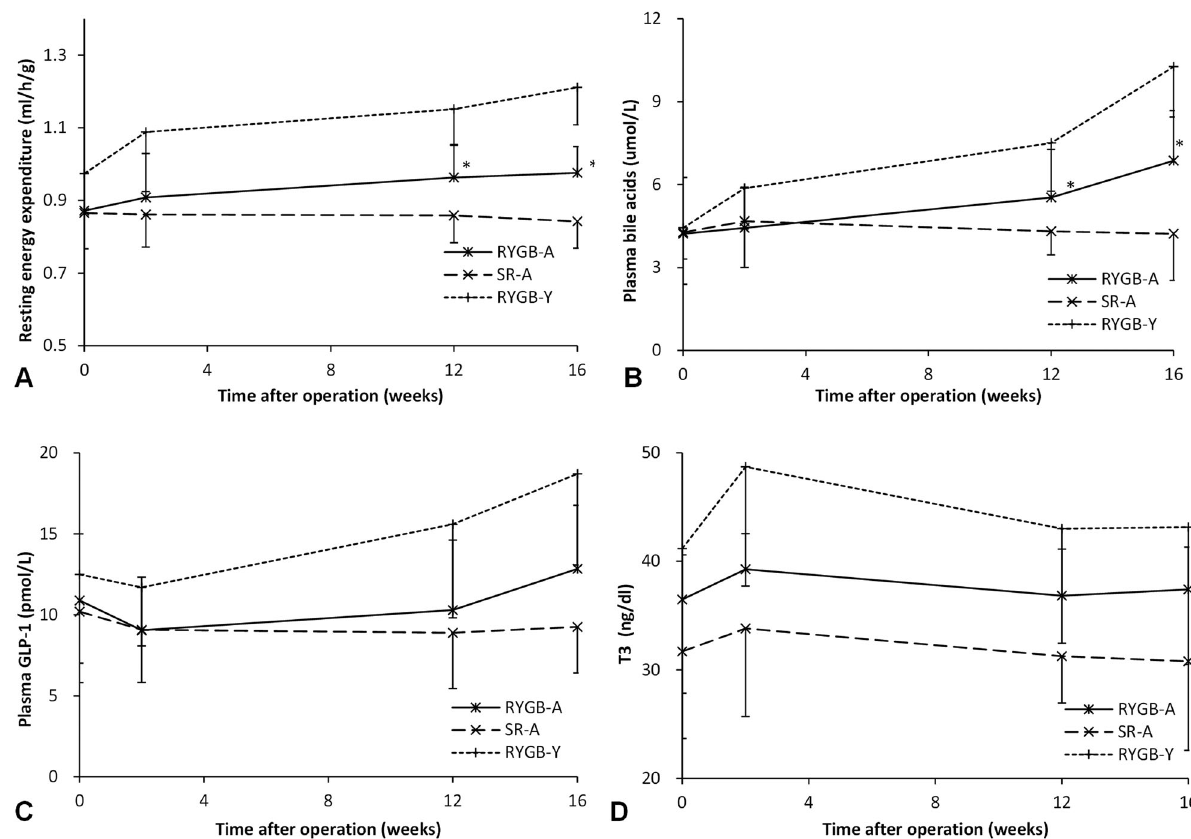
Fig. 4 Changes of resting energy expenditure, plasma bile acid level, GLP-1, and triiodothyronine. A The curve of resting energy expenditure. The resting energy expenditure of the RYGB-A group was signi fi cantly more than that of the SR-A group after surgery. B The plasma bile acid level of three groups. The bile acid level of the RYGB-A group was elevated signi fi cantly after surgery. C The plasma GLP-1 level of three groups. The GLP-1 level of the RYGB-A group at the 16th postoperative week was similar with that of the SR-A group. D The plasma triiodothyronine level of three groups. The level of triiodothyronine in the RYGB-A group was similar with that of the SR-A group. The asterisk means signi fi cantly different compared to the SR-A group ( P < 0.05). RYGB-A, aged rat with Roux-en-Y gastric bypass. SR-A, aged rat with sham Roux-en-Y gastric bypass. RYGB-Y, young rat with Roux-en-Y gastric bypass. T3,